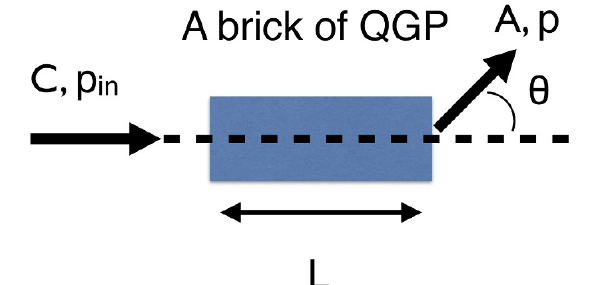
Figure 1 . Kinematics of the thought experiment that we analyze. An incident parton of \type" C (type meaning gluon or quark or antiquark) with energy p in impinges on a \brick" of QGP with thickness L . An outgoing parton of type A with energy p is detected at an angle (cid:18) relative to the direction of the incident parton. We shall calculate the probability distribution of p and (cid:18) for a given p in and for all possible choices A and C